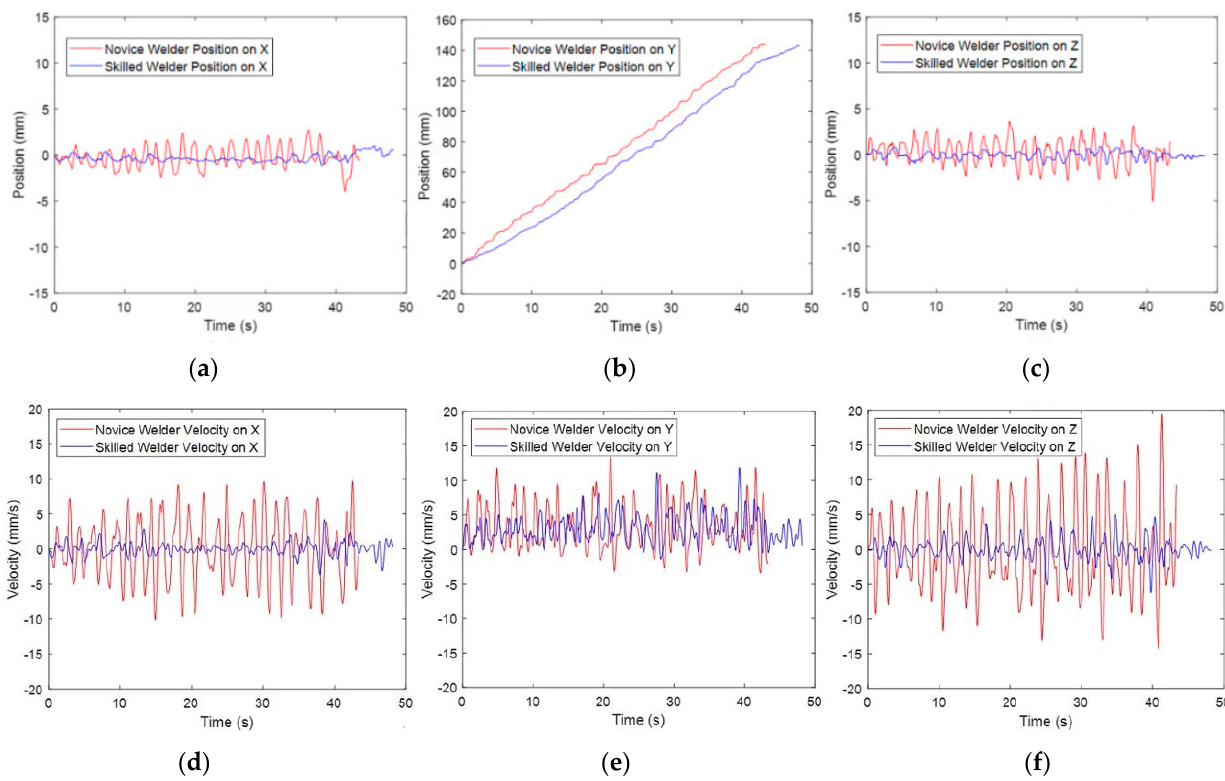
Figure 7. Sample welding motion of skilled and novice welders. Direct comparison of ( a ) back and forth movement perpendicular to the direction of welding movement (X); ( b ) movement in the direction of welding movement (Y); ( c ) up and down movement perpendicular to the direction of welding movement (Z). ( d – f ) show the associated (X, Y, Z) velocities. Table 1. Mean statistic results for objective movement measures for each direction.